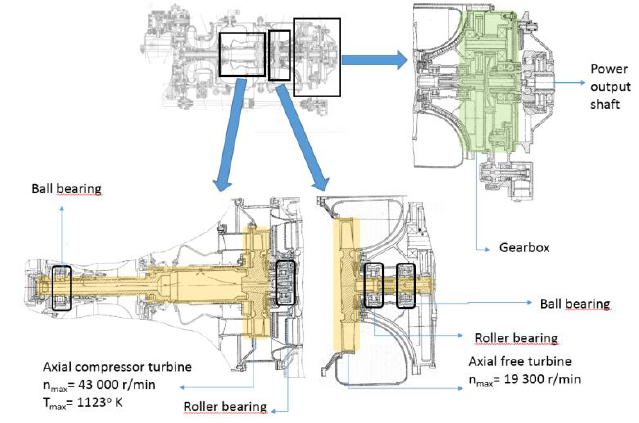
Figure 7. Cross-section of the GTDE-117 engine (Adapted from [22]).